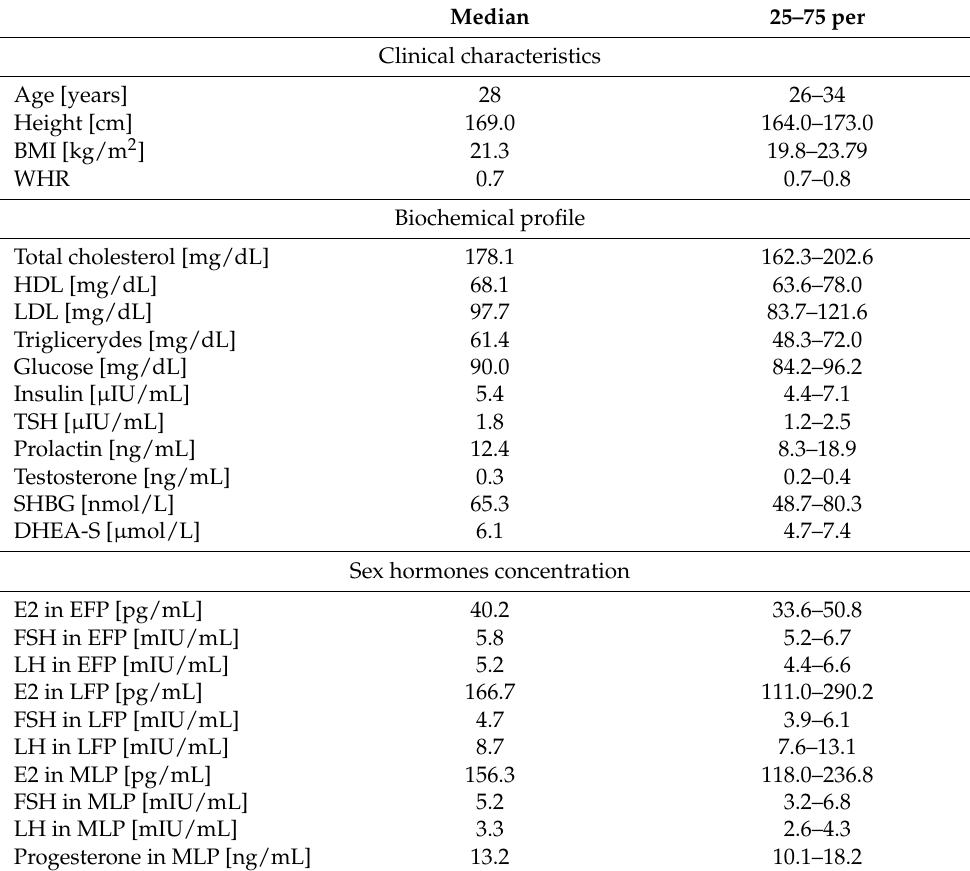
Table 1. The concentration of sex hormones and clinical characteristics of healthy women with regular menstrual